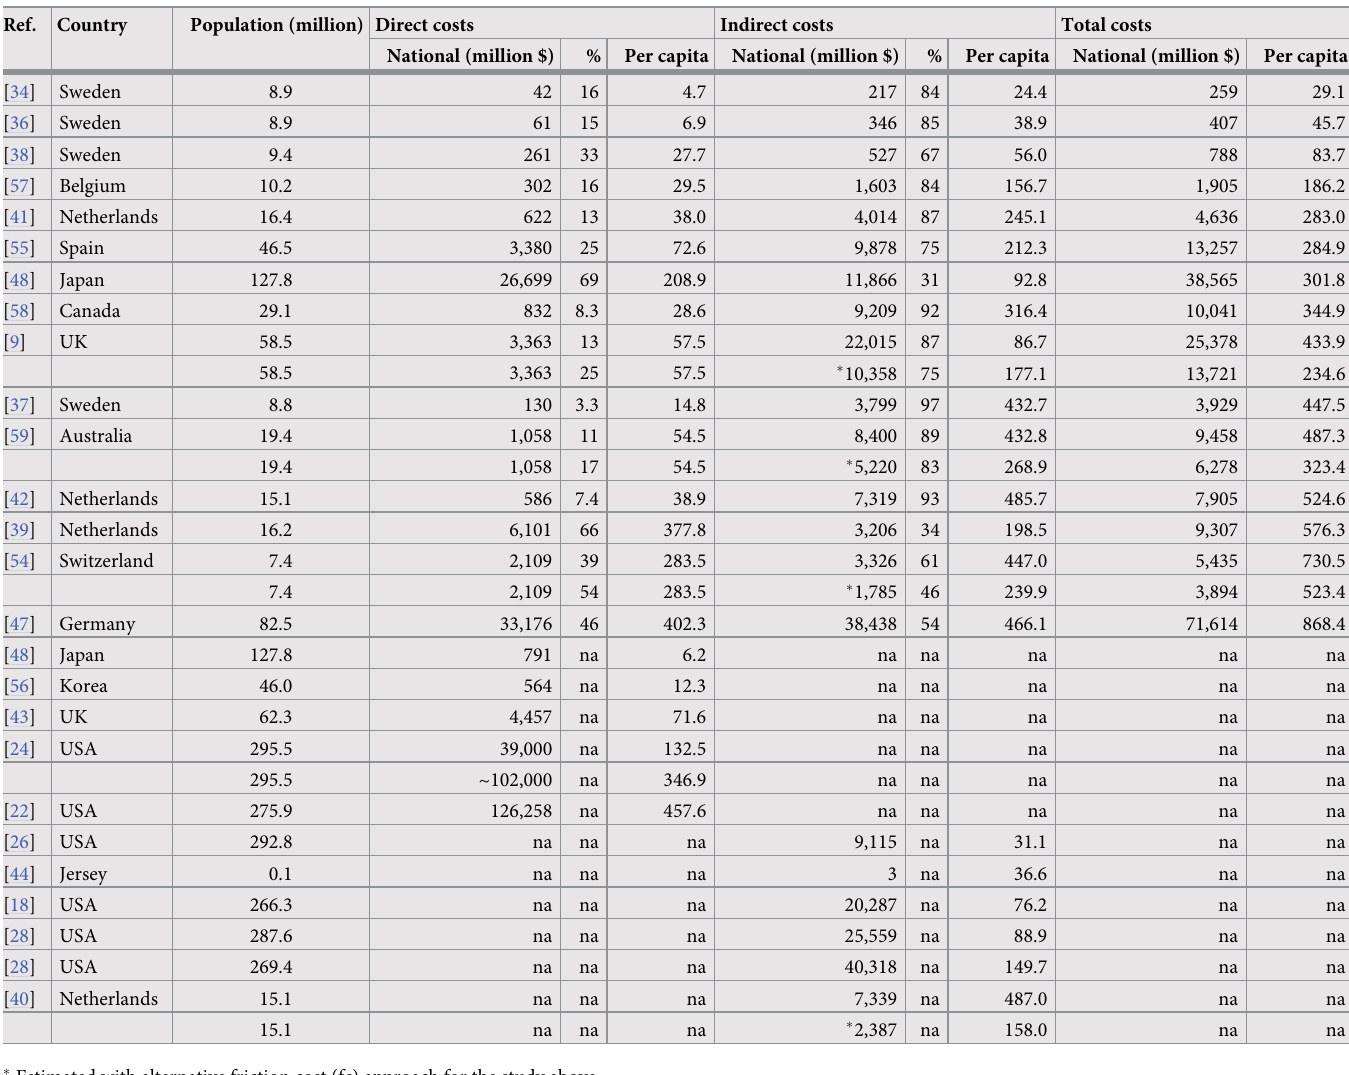
Table 4. National estimates of direct, indirect, and total costs of back pain. Ref.